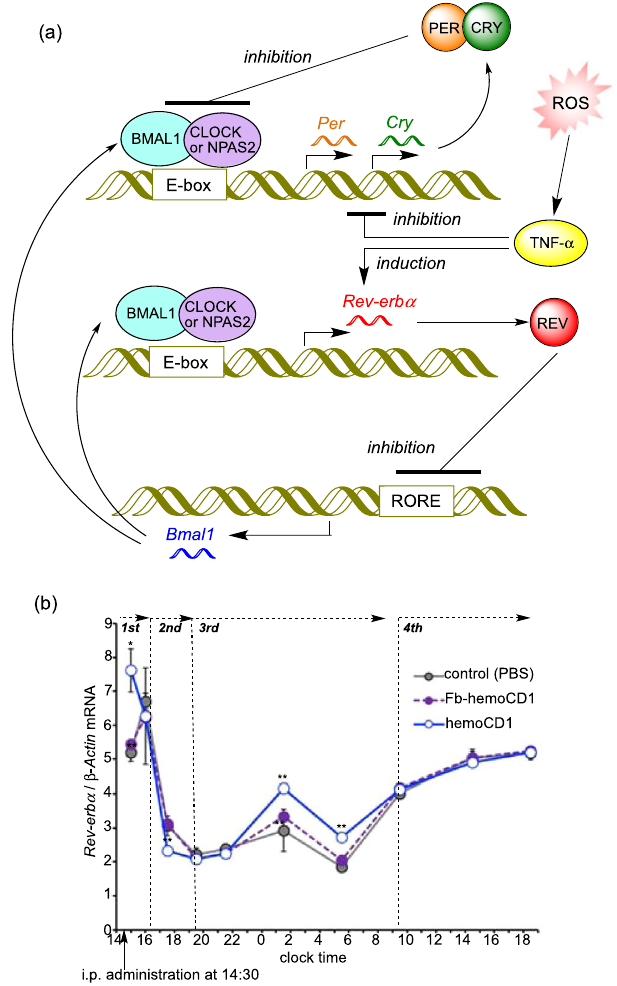
Figure 7. ROS-induced circadian rhythm disruption mediated by TNF- α . ( a ) Schematic representation of the clock system involving Rev-erb α . Similar to Per and Cry , BMAL:CLOCK(NPAS2) enhances transcription of Rev-erb α . Additionally, TNF- α , which inhibits Per and Cry , slightly induces Rev-erb α . REV proteins inhibits the expression of BMAL1. ( b ) Changes in the relative mRNA levels of Rev-erb α in the murine liver after i.p. administration of hemoCD1. The mice were housed for two weeks under a 12 h light/dark (LD) cycle (lights on at 7:00 and light off at 19:00) until the day before the experiments. The mice were then housed under constant dark (DD) conditions during the observations. PBS and Fb-hemoCD1 were similarly administered as controls. Each bar represents the mean ± SE ( n = 3 mice per group). Asterisk denotes statistical significance ( * P < 0.05, ** P < 0.01), as compared to the controls. The components of Fig. 7a were drawn using